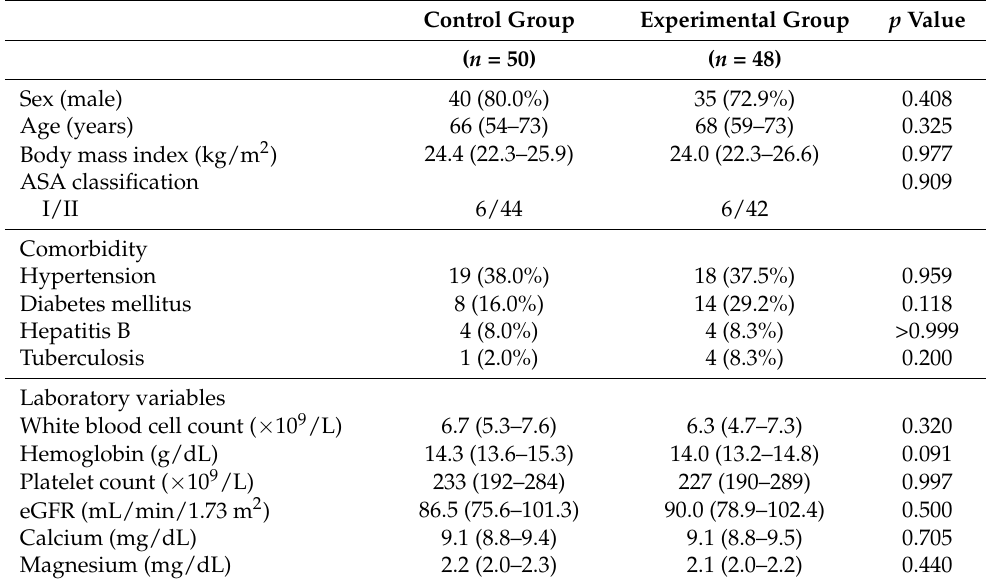
Figure 1. Study diagram. ASA-PS, American Society of Anesthesiologists Physical Status (clas- sification system); eGFR, effective glomerular filtration rate; TURBT, transurethral resection of bladder tumor. Table 1. Comparisons of preoperative findings between the control and experimental groups.